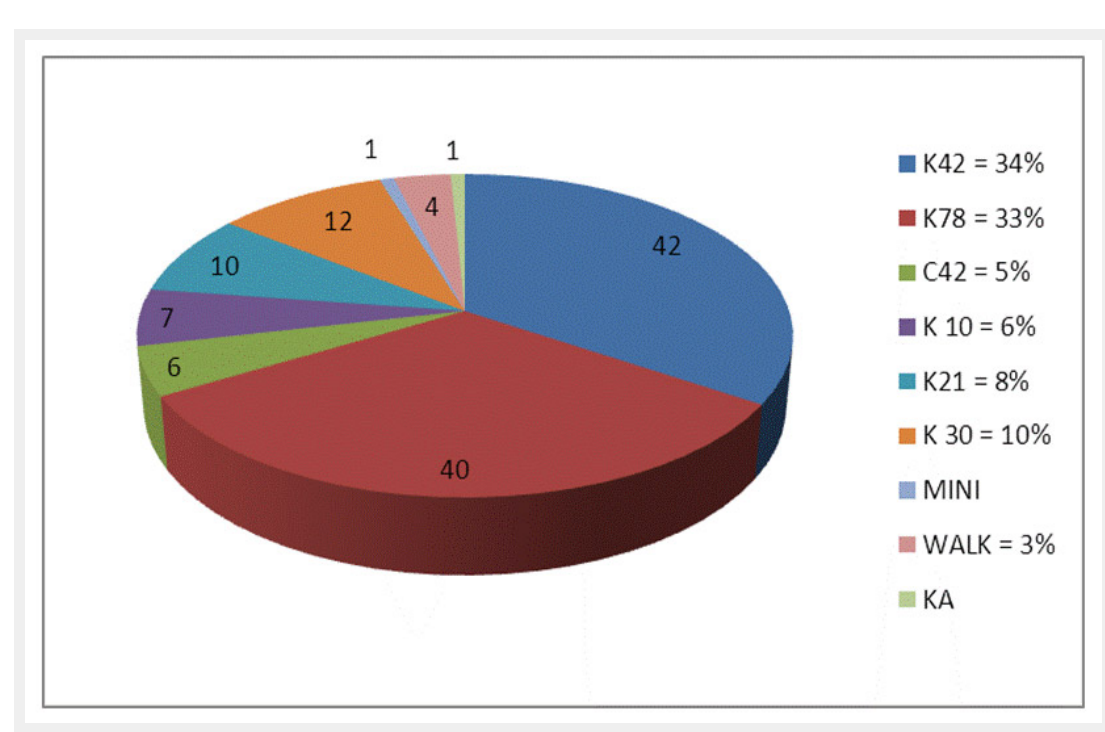
Figure 1 Distribution of the different categories within the group of athletes that completed the questionnaire.